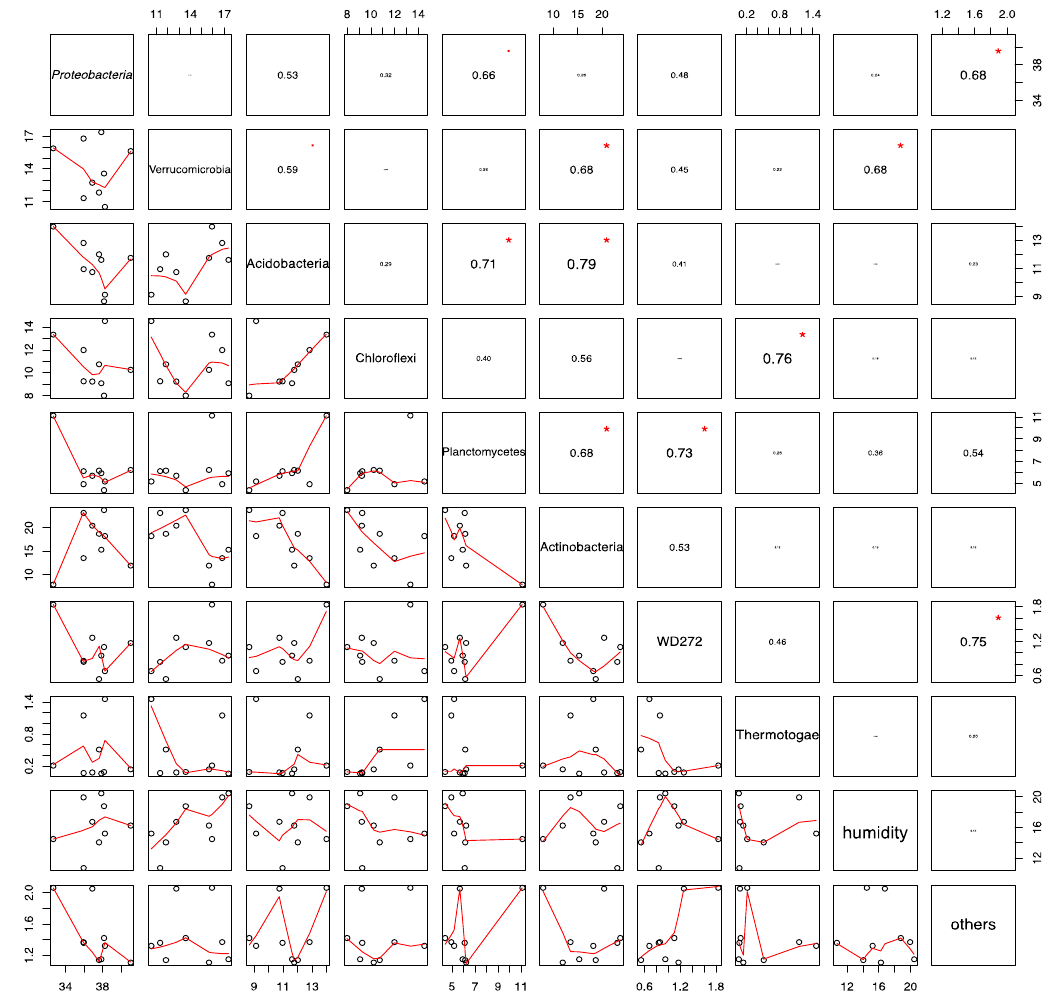
Figure A2. Correlation between the most abundant phyla in the soil and humidity. Linear regression analysis between bacterial phyla and soil moisture content for the Cerrado soil (60 cm depth), mound surface (0 cm), and mound soil (60 cm depth) samples. The numbers shown represent the R value in the linear regression, and the * symbol in red are statistically significant values.